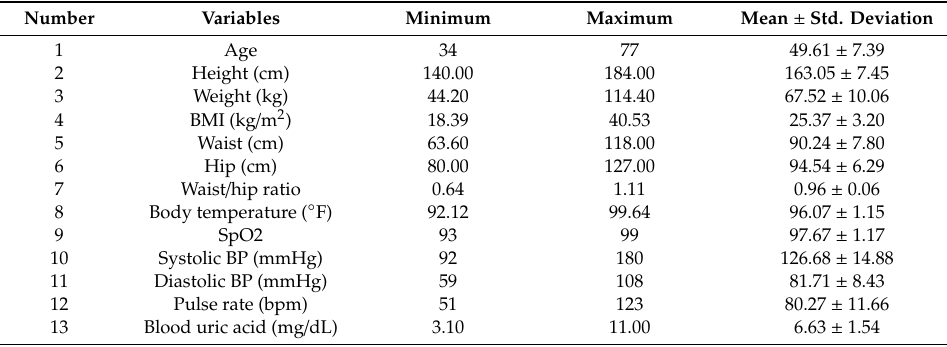
Table 3. Summary statistics of the selected continuous predictors ( n =